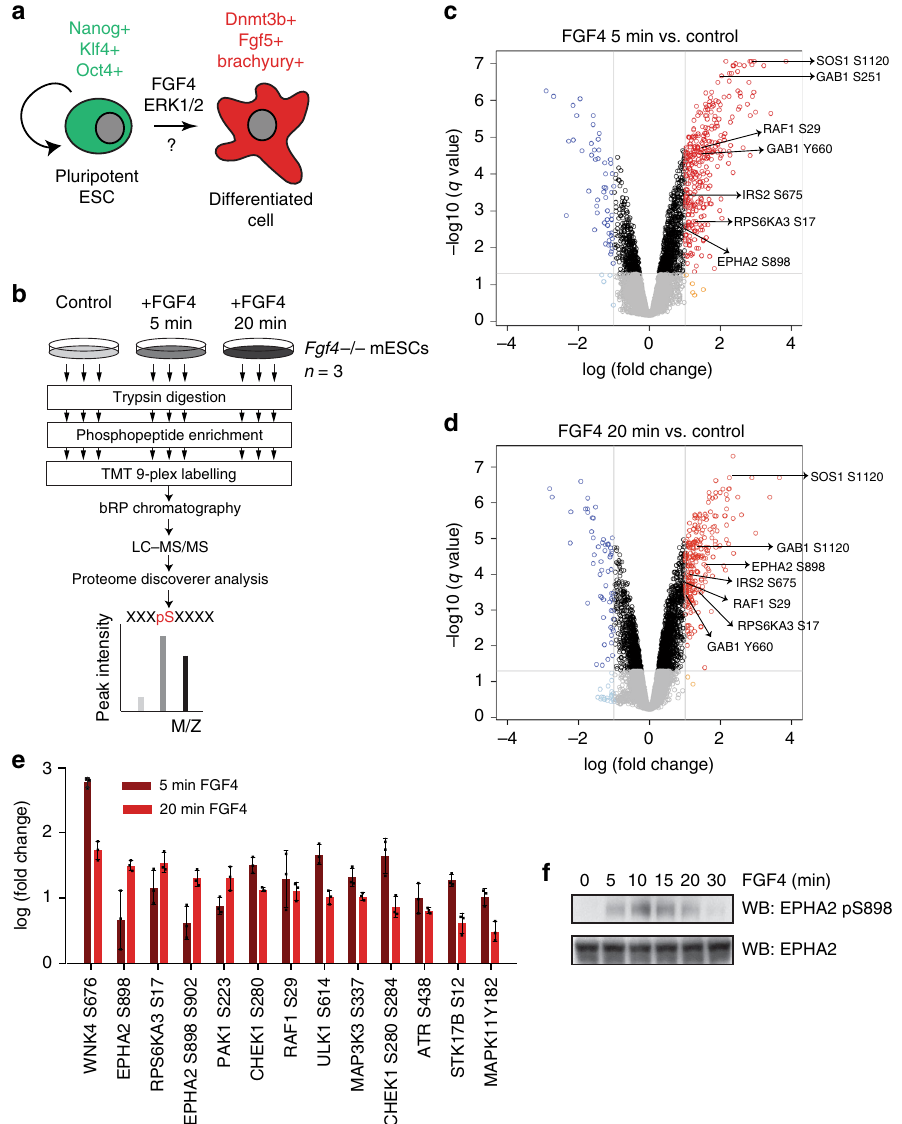
Fig. 1 FGF4 signalling in mESCs promotes EPHA2 Ser phosphorylation. a FGF4 is a key signal that promotes differentiation of pluripotent mESCs. b Work fl ow for phosphoproteomic analysis of FGF4 signalling in Fgf4 − / − mESCs. Volcano plot showing signi fi cantly modi fi ed phosphosites after stimulation of Fgf4 − / − mESCs with FGF4 for 5 min ( c ) and 20 min ( d ). Phosphosites on known FGF4 pathway components are highlighted. e Protein kinase phosphopeptides that are signi fi cantly upregulated (>2-fold) on at least one time point (5 or 20 min) compared with control. Data are presented as mean ± SD ( n = 3). f Fgf4 − / − mESCs were stimulated with FGF4 for the indicated time, and EPHA2 pS898 and EPHA2 levels determined by immunoblotting. Source data are provided as a Source Data fi